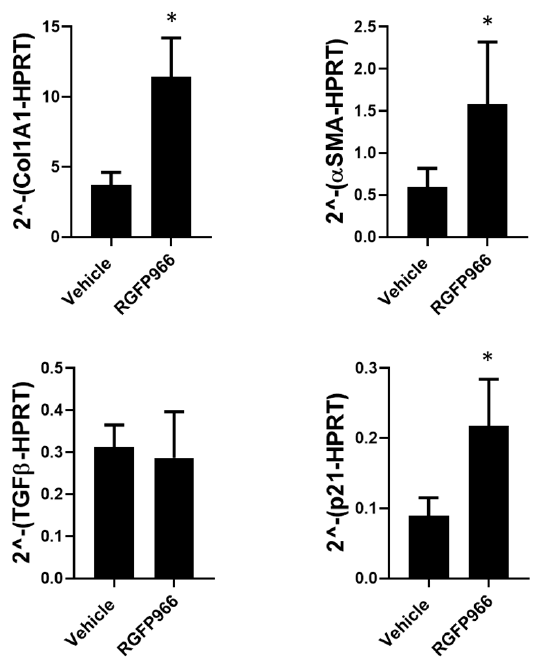
Figure 4. Pharmacological inhibition of HDAC3 by RGFP966 regulates the expression of profibrotic genes. qPCR analysis of fibrosis-related genes: Col1A1, α SMA, TGF β , and p21; control fibroblasts treated with RGFP966 10 µ M for 24 h from three independent experiments. * p < 0.05 by unpaired Student’s t -test.